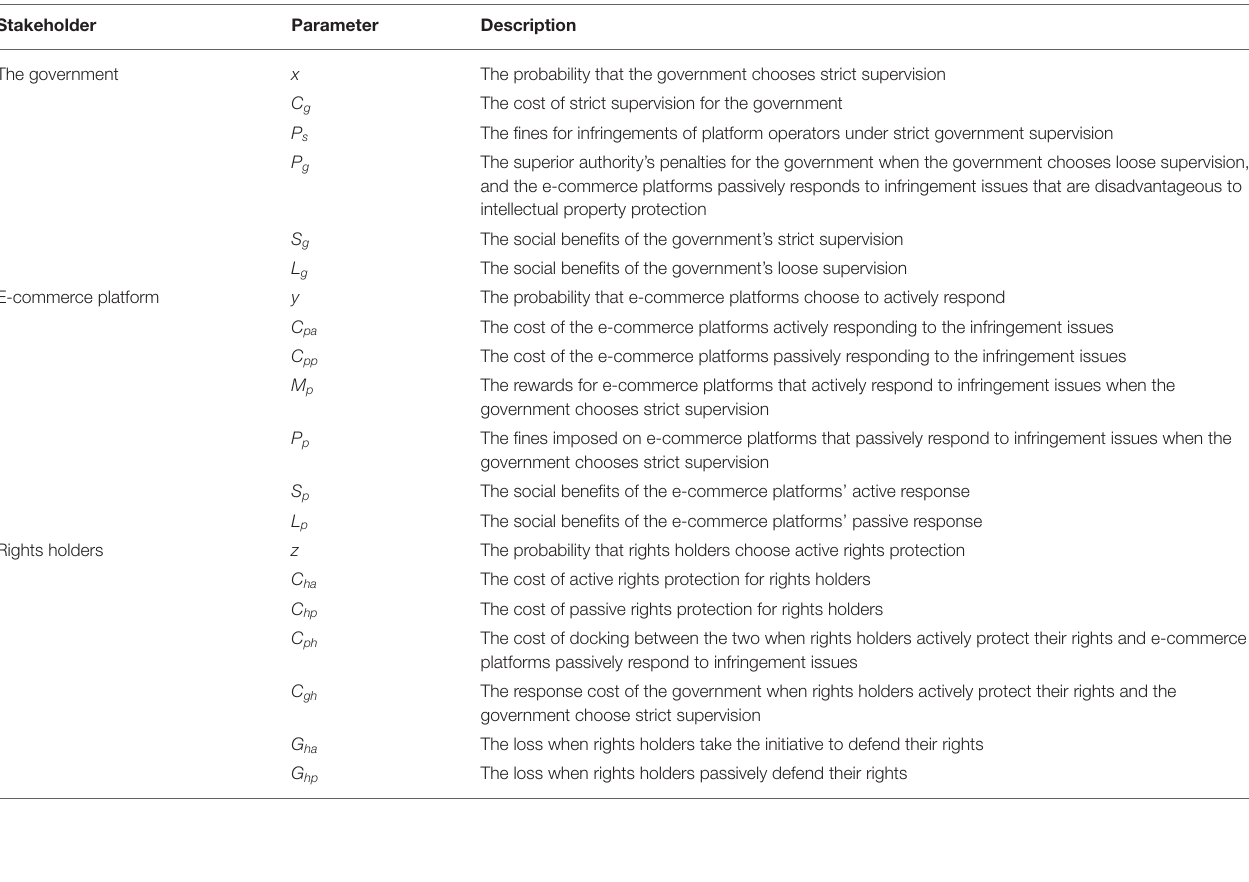
TABLE 1 | Parameter